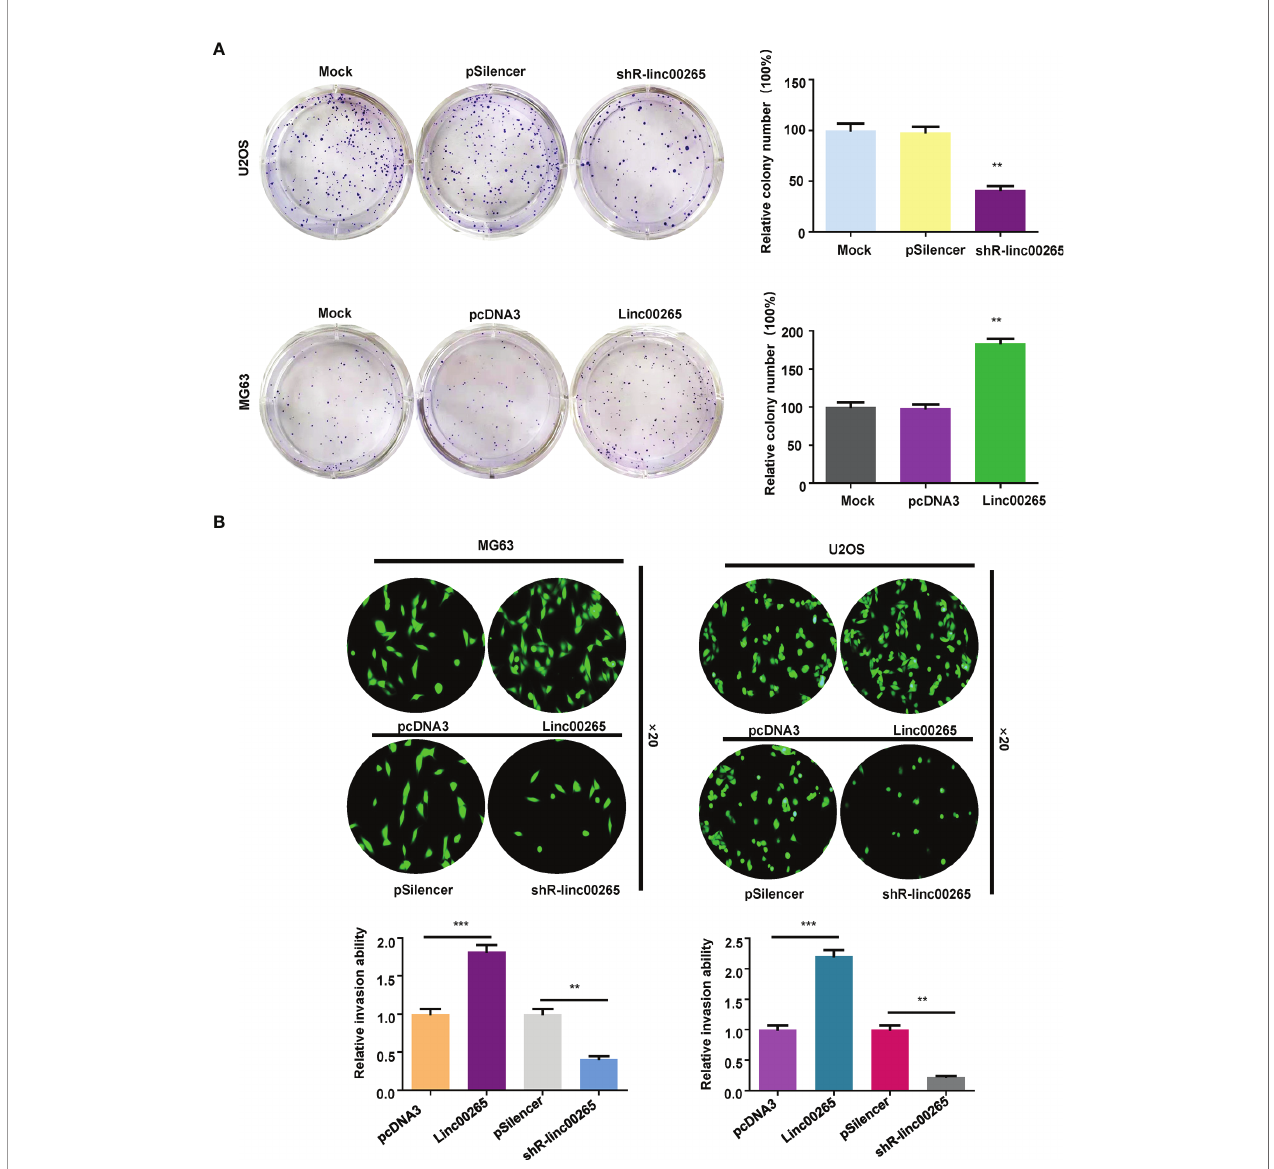
FIGURE 2 | Linc00265 overexpression promotes colony formation and invasion of osteosarcoma cells. (A) Colony formation assay was used to detect the ability of colony formation in osteosarcoma cells after linc00265 downregulation (U2OS cells, Top) and upregulation (MG63 cells, Bottom). The quantitative data were illustrated (Right panel). (B) Transwell invasion assays were conducted in MG63 and U2OS osteosarcoma cells after linc00265 overexpression or downregulation. The quantitative data of invasion ability were shown (Bottom panel). ** P < 0.01, *** P < 0.001 vs.